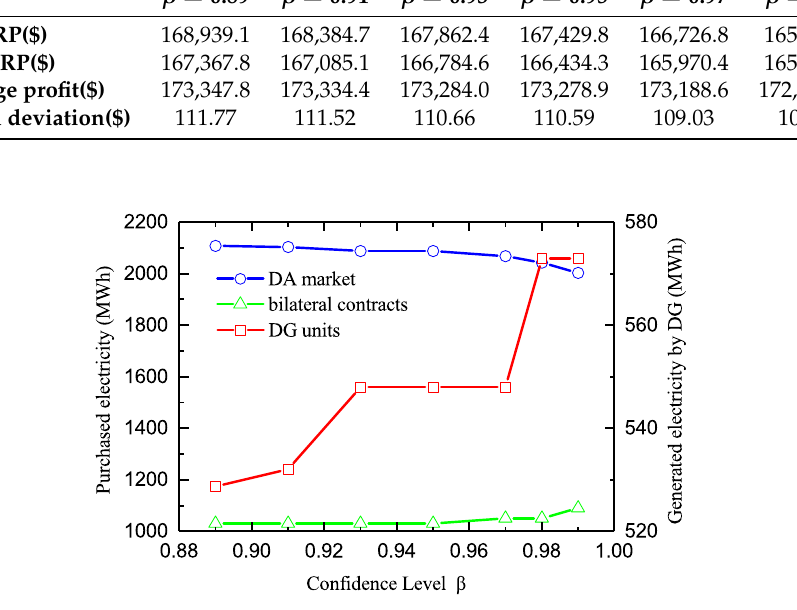
Figure 4. Volumes of electricity purchased under different confidence